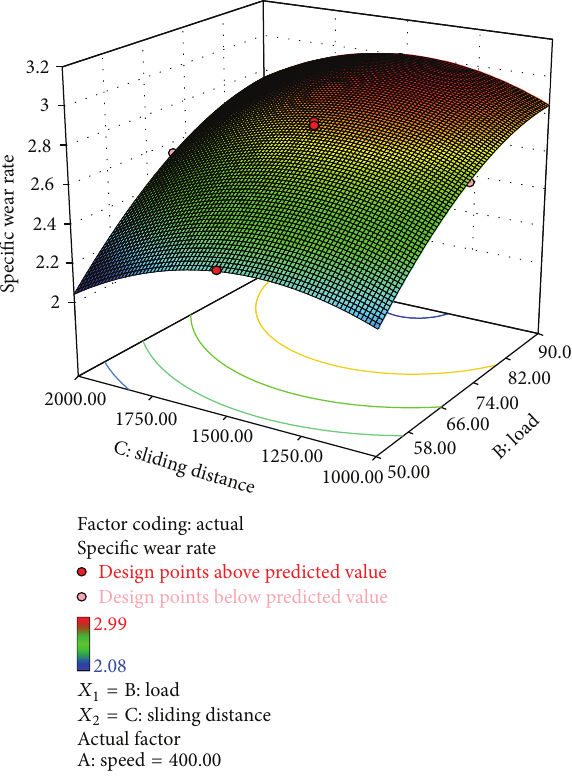
Figure 5: 3D response plot for specific wear rate (mm 3 /Nm) with the change of sliding distance and applied normal